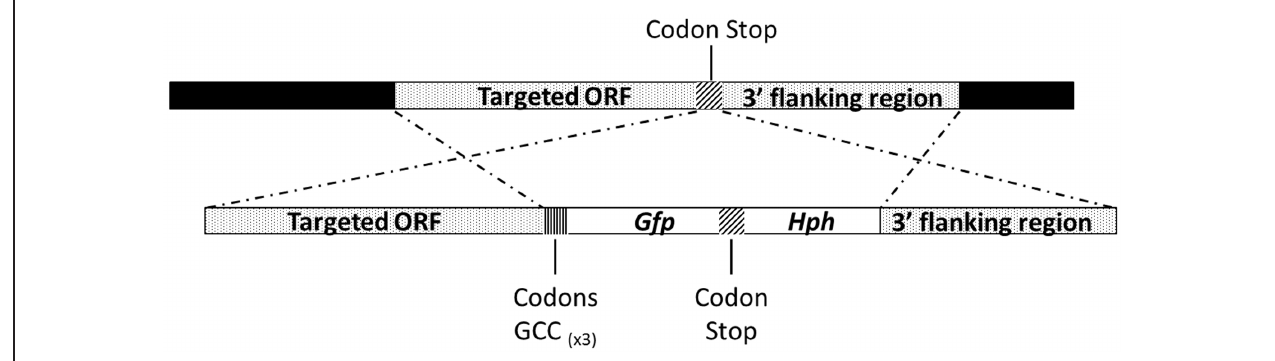
FIGURE 2 | Schematic representation of the AbMpd and AbMdh loci (dotted boxes) and replacement constructs with the GFP and HygB resistance ( Hph ) genes (white boxes).